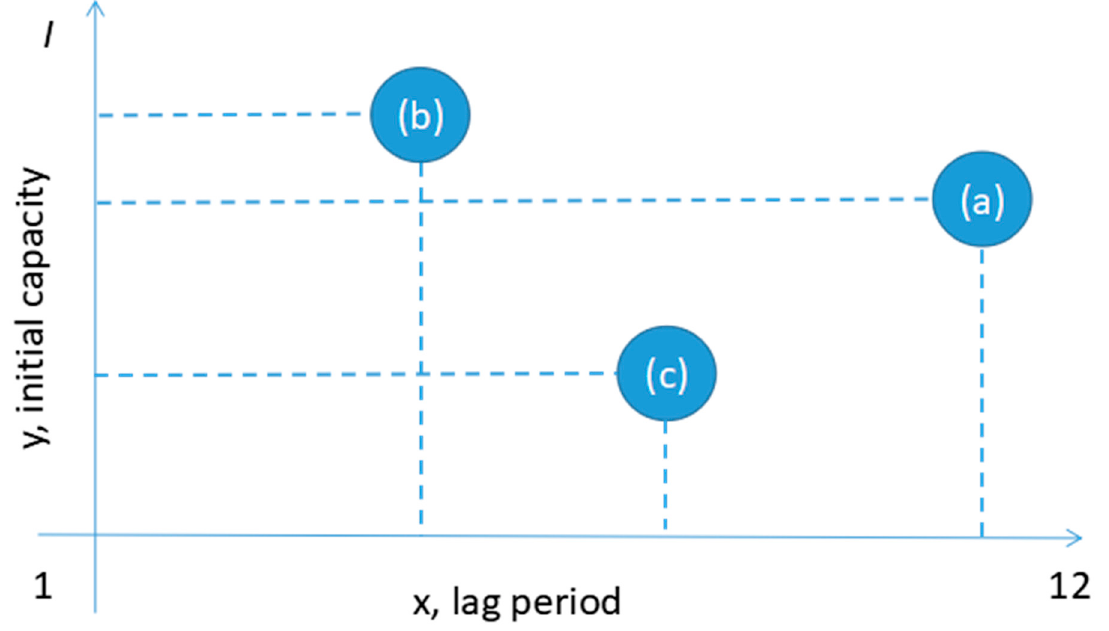
Figure 2. Optimizing objectives